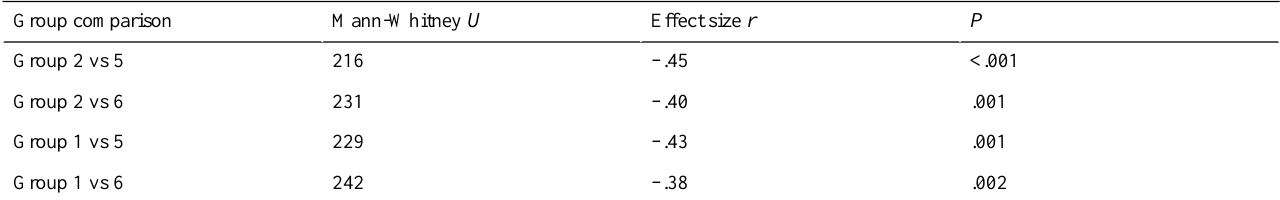
Table 4. Differences among groups in assessment of information